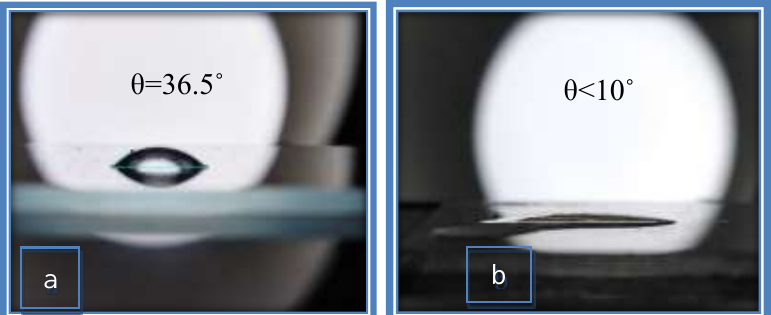
Fig .6: Images of water droplet on the sample pure TiO (T): a- without UV irradiation, 2 b- after15 min. of UV irradiation.